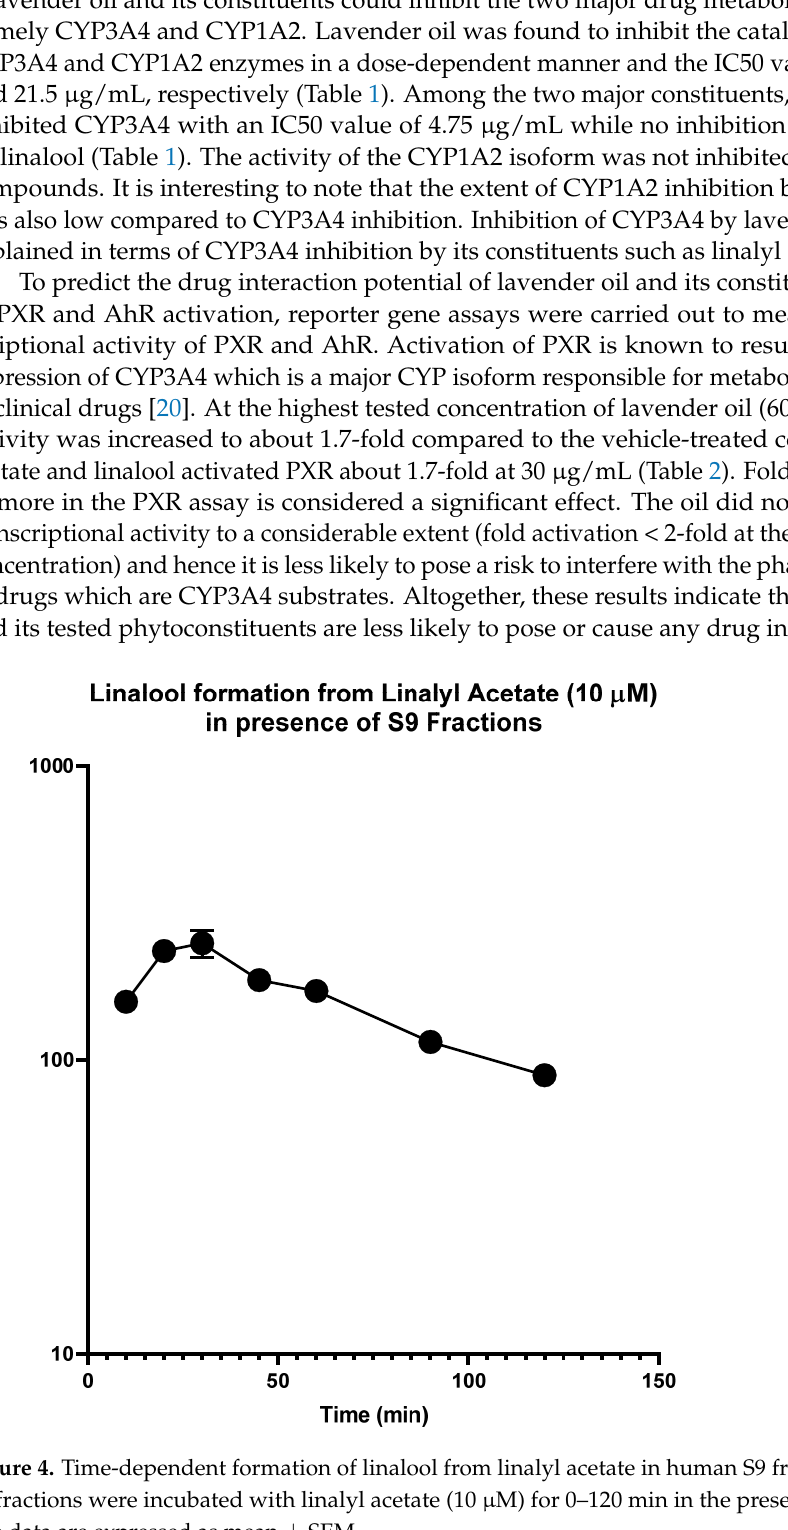
Figure 4. Time-dependent formation of linalool from linalyl acetate in human S9 fractions. Human S9 fractions were incubated with linalyl acetate (10 µ M) for 0–120 min in the presence of cofactors. The data are expressed as mean ±